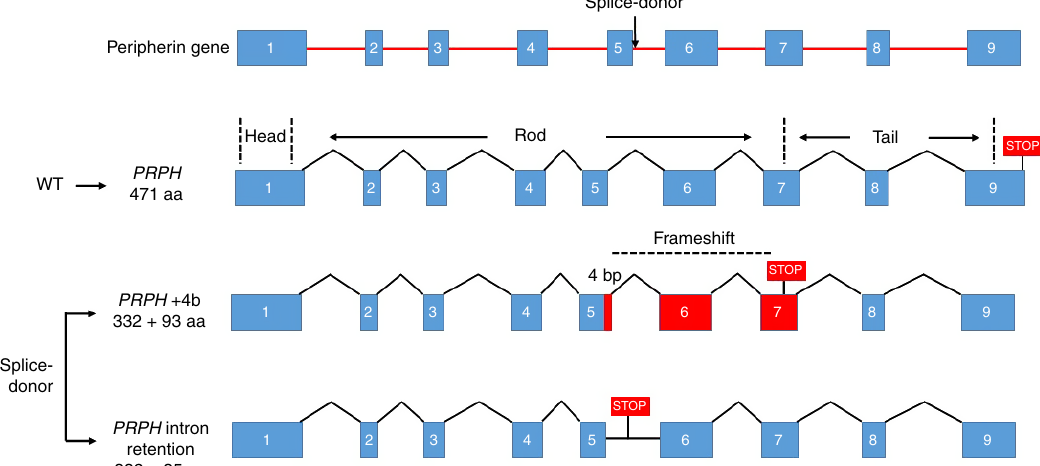
Fig. 3 PRPH contains nine exons. The wild-type (WT) protein consists of a head domain expressed by exon 1, a rod domain expressed by exons 2 – 7, and a tail domain expressed by exons 7 – 9. The PRPH splice donor variant rs73112142-A is in the fi rst base site after the fi fth exon. Defective splicing generates two truncated frameshift variant proteins. In both cases the truncated proteins retain the fi rst 332 amino acids; then, either four extra base pairs are added at the end of exon 5 putting protein out of frame after exon 5 and creating a STOP after 93 amino acids (coded by exons 6 and 7), or read-through into intron 5 occurs, with STOP after 35 amino acids (encoded by intron 5) NATURE COMMUNICATIONS| (2019) 10:1777